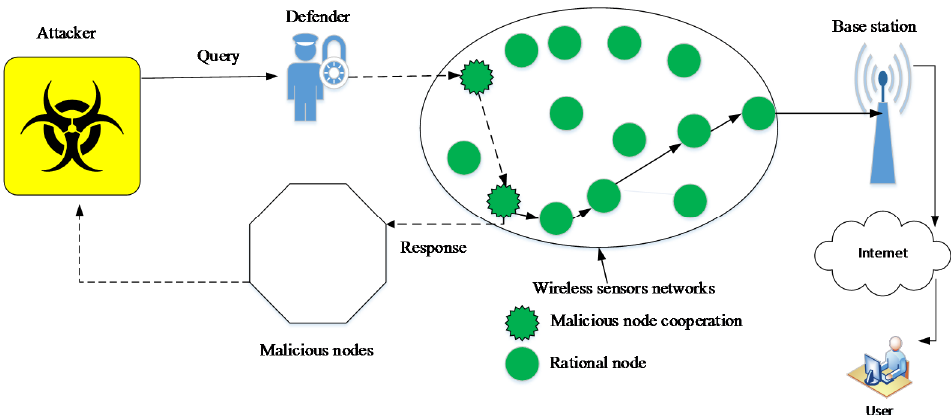
Figure 3. The architecture for all rational nodes choosing defense.